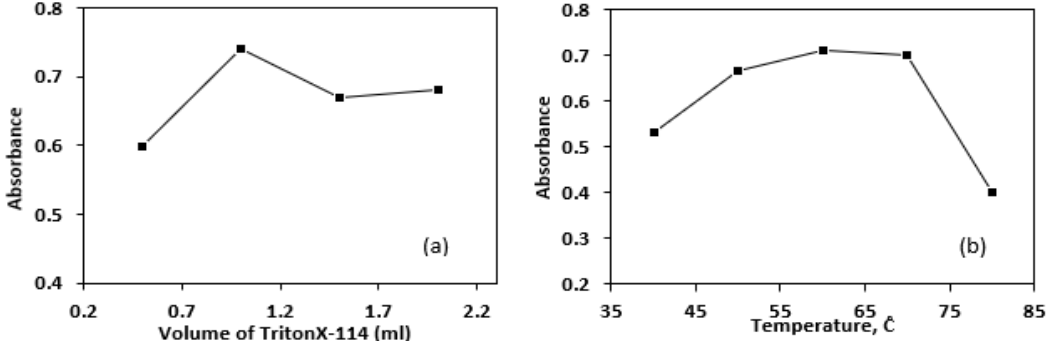
Figure. 6. Study the effect of (a) volume of Triton X-114 (b) incubation temperature (CPE conditions: 4 µg/ml of ISX; incubation time, 30 min; sulfadimidine, 2 mM; NaOH, 0.1 M